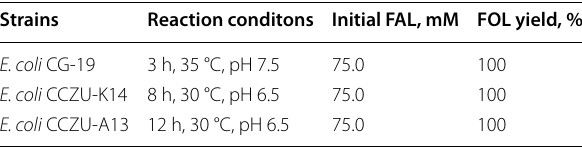
Table 2 Bioreduction of FAL to FOL with reductase‑producing strains